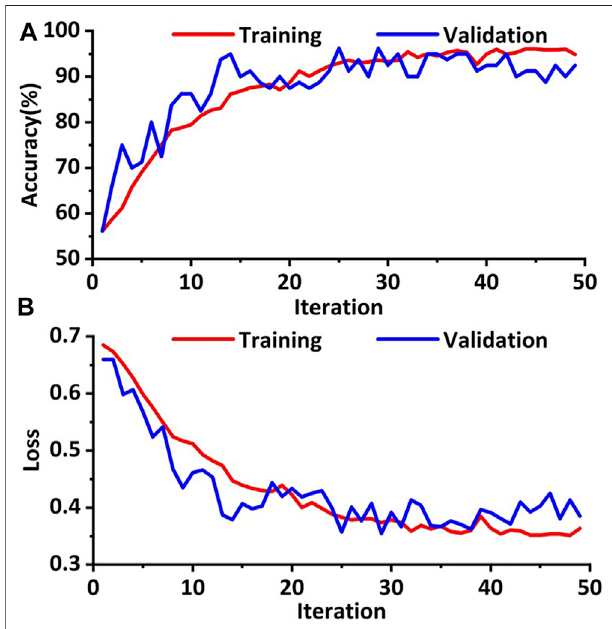
FIGURE 3 | Training and validation processes of the deep learning model based on the CT images. (A) The accuracies of training and validation cohort via the ghost network model were approximately 98.0%. (B) The fi nal training and validation losses were close to 0.4.